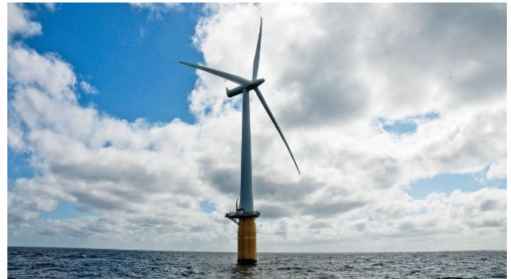
Figure 1. Hywind Demo.